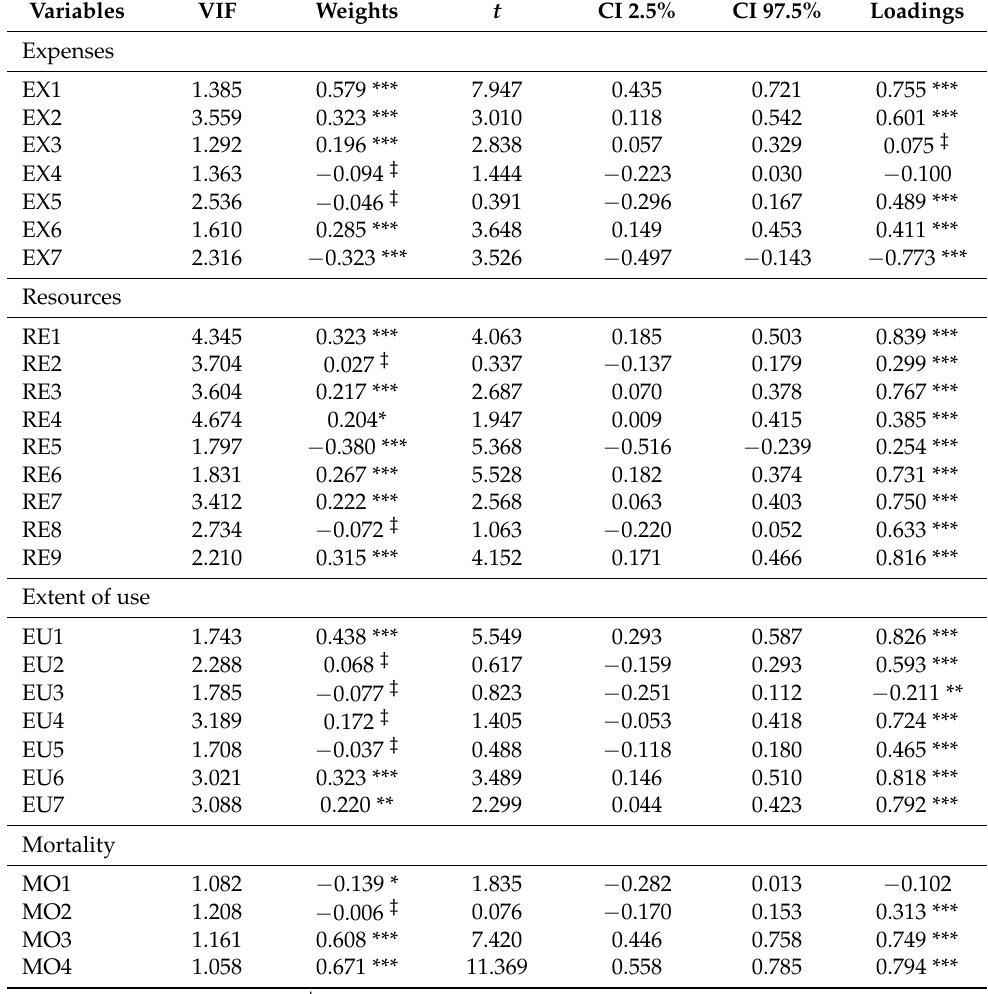
Table 5. Assessment of measurement model. Estimated constructs in mode B for